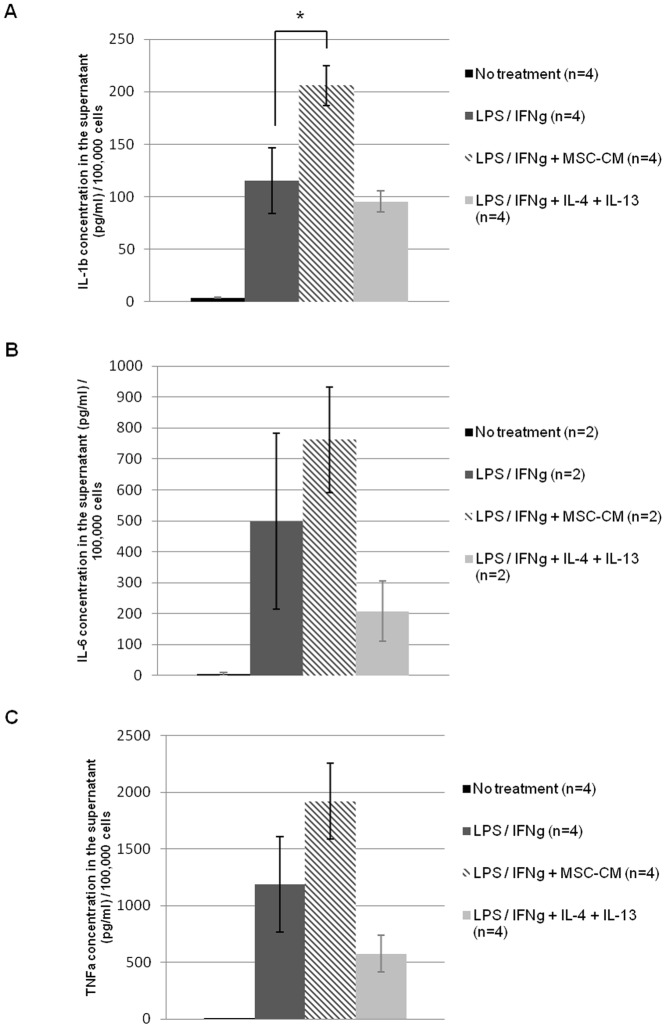
BMSC-CM stimulates macrophages to secrete pro-inflammatory cytokines.Concentration of IL-1β (A), IL-6 (B) and TNFα (C) in the supernatant of macrophages cultured in various conditions: non-activated, activated with LPS and IFNγ with or without 25% BMSC-CM, or with IL-4 and IL-13. BMSC-CM increases significantly IL-1β secretion by macrophages and tends also to increase their IL-6 and TNFα secretion. Experiment was repeated 2 to 4 times. * p<0.05.